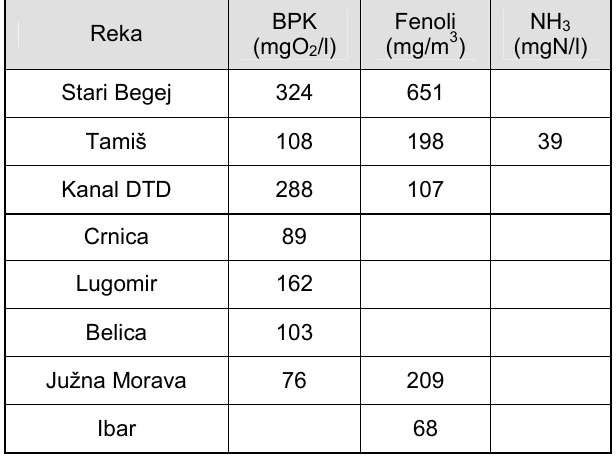
Vrednost nekih parametara koji ekstremno prelaze MDK vrednosti u površinskim vodama Republike Srbije Value of some parameters exceeding the MDK to extreme values in the surface waters of the Republic of Serbia BPK Reka (mgO 2